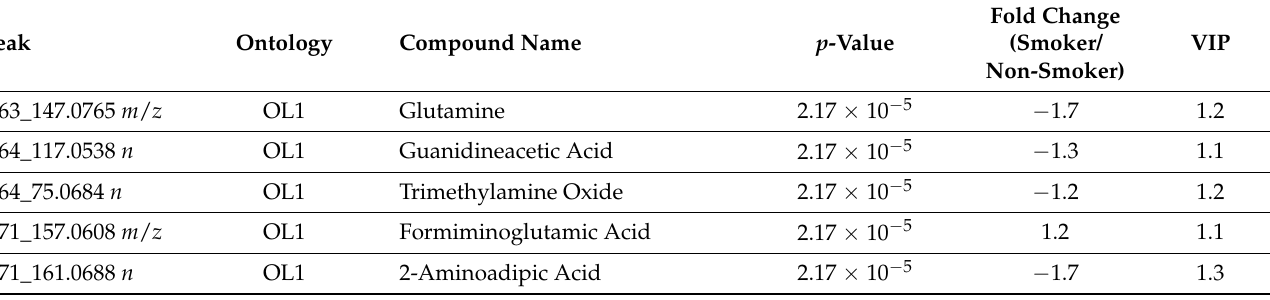
Table 4. Top 50 significantly altered metabolites between tobacco smokers’ and non-smokers’ NIST reference